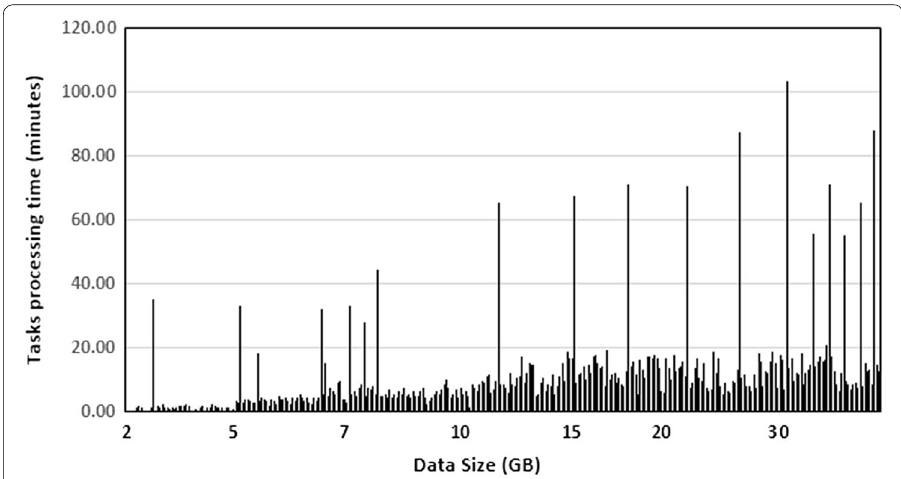
Fig. 8 A number of 319 Pig script tasks, including repeated tasks: Pig script operates between disks and memory. This creates many interruptions in the busy network. Therefore, the fail percentages in Pig tasks is high. The failure percentage increases parallel with the data size